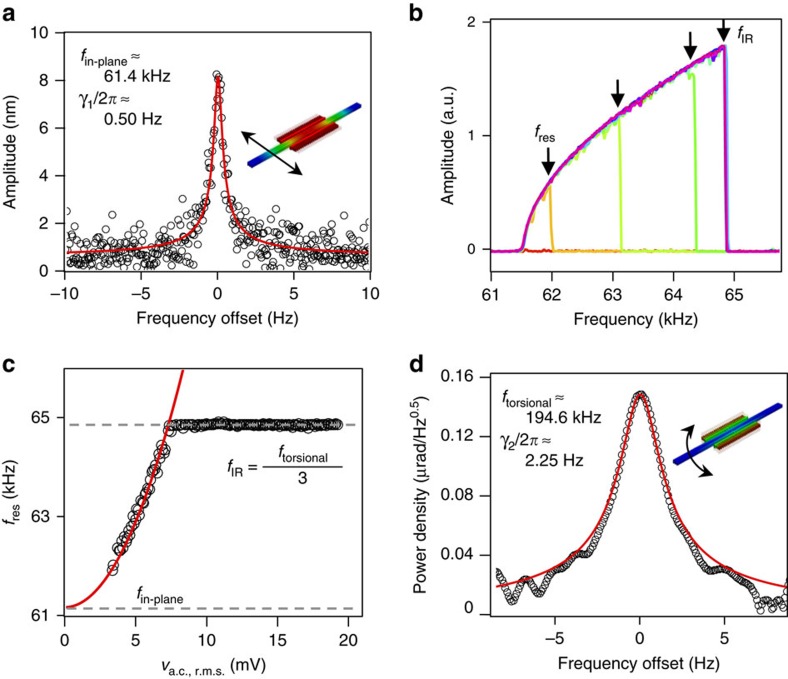
Internal resonance in a nonlinear MEMS oscillator.(a) Linear resonance of the in-plane oscillation mode measured with open-loop set-up, d.c. bias Vd.c.=7 V, and alternating current (a.c.) voltage actuation va.c.=40 μV (r.m.s.). The black circles are acquired data, and the red curve is the corresponding Lorentzian fit. Inset: finite element simulation of the in-plane mode shape (CoventorWare). The length and thickness of the c–c beam are 500 and 10 μm, respectively. The central portion consists of three parallel beams, each with width of 3 μm. (b) The vibrational amplitude of the in-plane motion as the external excitation frequency is swept up (open-loop), with excitation amplitude va.c. increasing from 1 to 19 mV at 2 mV steps. At large va.c., the vibrational amplitude spectrum shows an asymmetrical line-shape that skews towards high frequencies, due to the positive Duffing nonlinearity. As va.c. increases, the frequency at which the vibrational amplitude peaks, fres, also increases, until reaching ≈64.9 kHz. (c) Measured fres (black circles) with different va.c.. For ≲7.5 mV, fres follows a quadratic dependence (red curve) on va.c.. For ≳7.5 mV, fres stabilizes around 64.9 kHz, which equals to one third of ftorsional. Notice that all the voltages are r.m.s. values. (d) Thermomechanical noise spectrum of the torsional mode measured with optical interferometry. The black circles are acquired data, and the red curve is the corresponding Lorentzian fit.